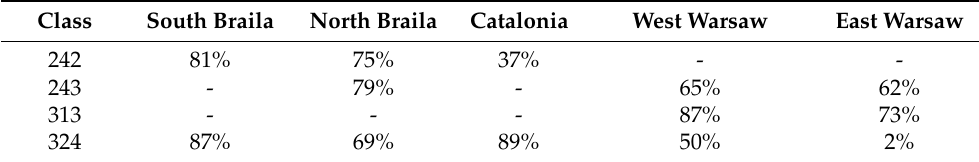
Table 12. F1-score indices of heterogeneous